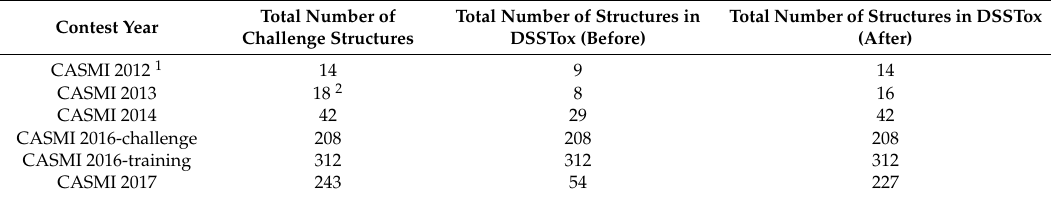
Table 1. Number of structures in each Critical Assessment of Small Molecule Identification (CASMI) contest year and the number of those present in DSSTox before and after database